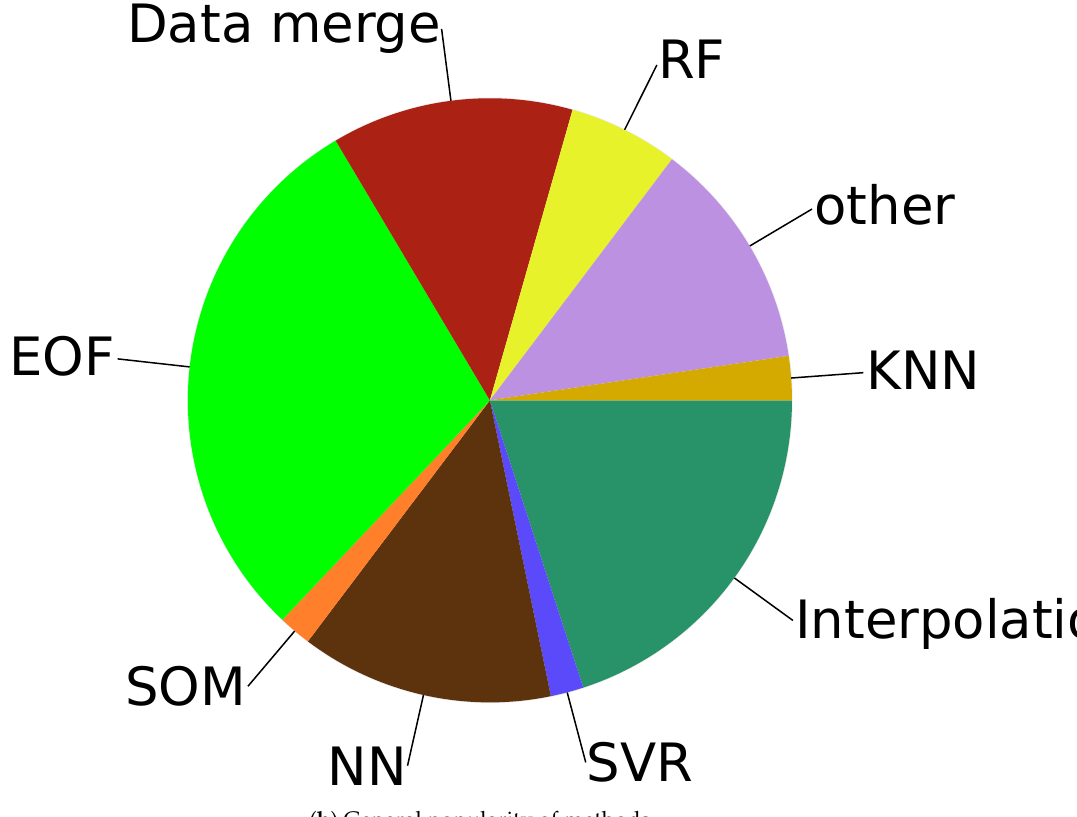
Figure 7. Visualisation of the popularity of the methods. While ( a ) showcases the aforementioned trend in popularity, ( b ) displays the overall popularity of methods, with EOF-based methods being the most